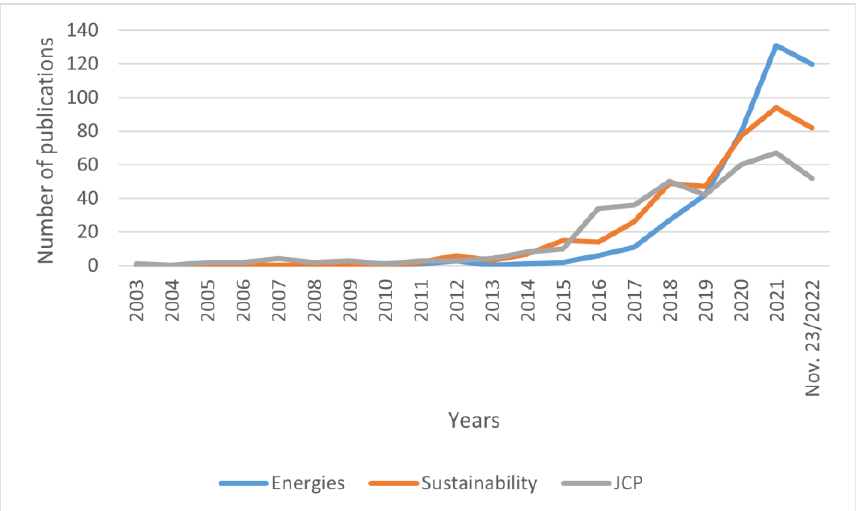
Figure 4. Evolution in the number of articles published by the top 3 journals in sustainable development and renewable energy over time.